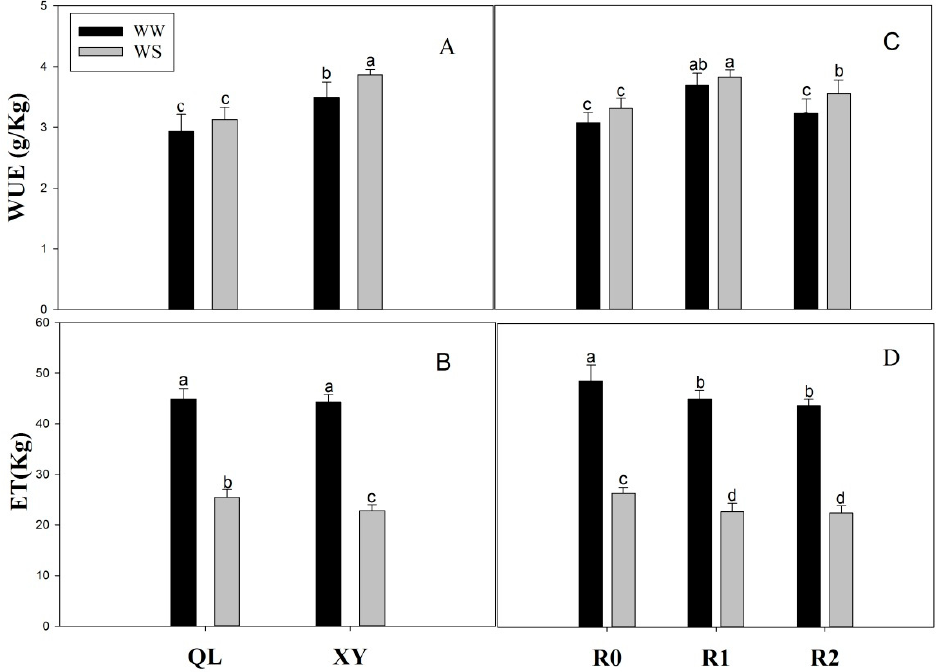
Figure 5. Water use efficiency (WUE) ( A ), evapo-transpiration (ET) ( B ) (irrigation throughout the growth period) in Experiment 1. WUE ( C ) and ET ( D ) in Experiment 2. Values are means ± standard error ( n = 6). Different letters indicate significant differences among treatments ( p < 0.05) based on Duncan’s test. The treatment abbreviations are defined in Figure 1.